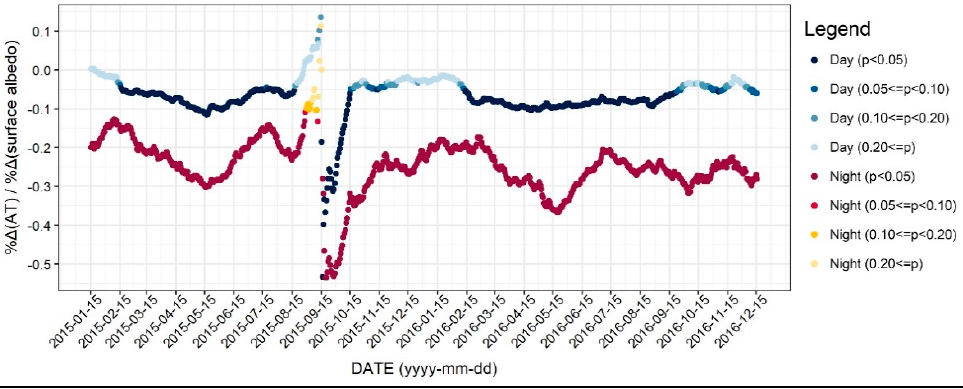
Figure 8. Changing patterns in the regression coefficients and their significances (surface albedo). Int. J. Environ. Res. Public Health 2019 , 16 , x FOR PEER REVIEW